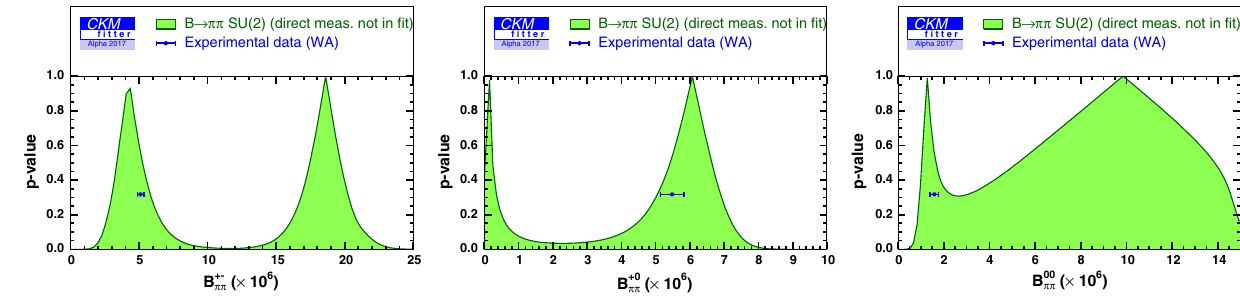
Fig. 26 Constraint on the B → ππ branching fractions from the SU ( 2 ) isospin analysis (from left to right : π + π − , π + π 0 and π 0 π 0 ). The direct measurement, not included in the fit, is indicated for each mode with an interval with a